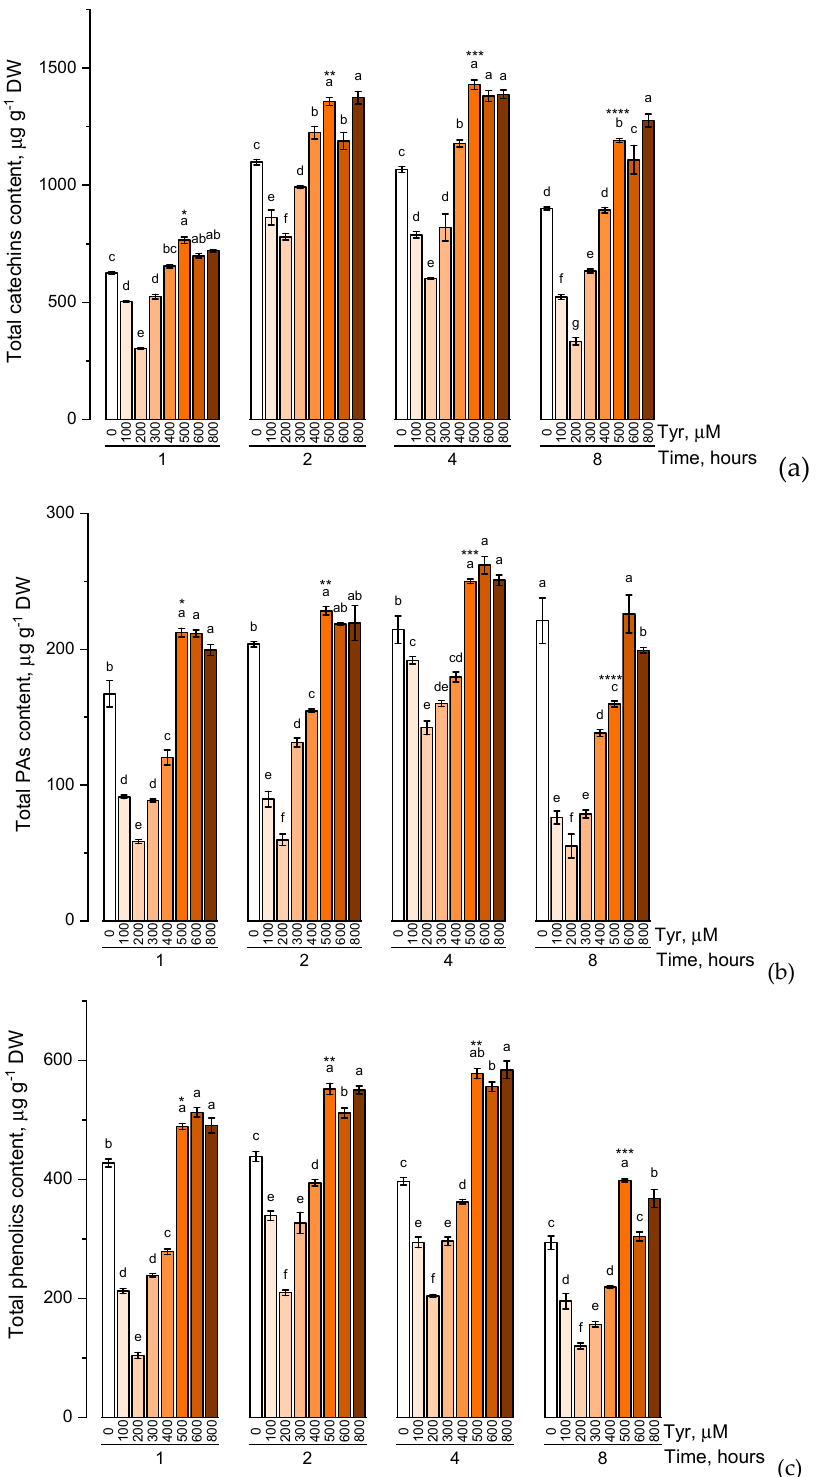
Figure 4. Accumulation of total catechins content ( a ), total proanthocyanidins content ( b ), total phenolic content ( c ) in wheat samples incubated on tyrosine-enriched medium containing various concentrations of the amino acid (100, 200, 300, 400, 500, 600, and 800 μ M) for 1, 2, 4, 8 h. Bars marked with different letters show significant differences for the defined time of cultivation with tyrosine; asterisk * indicates significant differences among plants exposed for a different time at 500 μ M ( p ≤ 0.05, Tukey’s test).